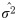
Individual and Cross-sectional Concavity (left) and Symmetry (right) v semester s.In both panels, the green triangles represent the cross-sectional variance, σ2^, and the blue dots stand for the individual variance, σ2˜. The values in the abscissae are normalised by the value in the first semester.